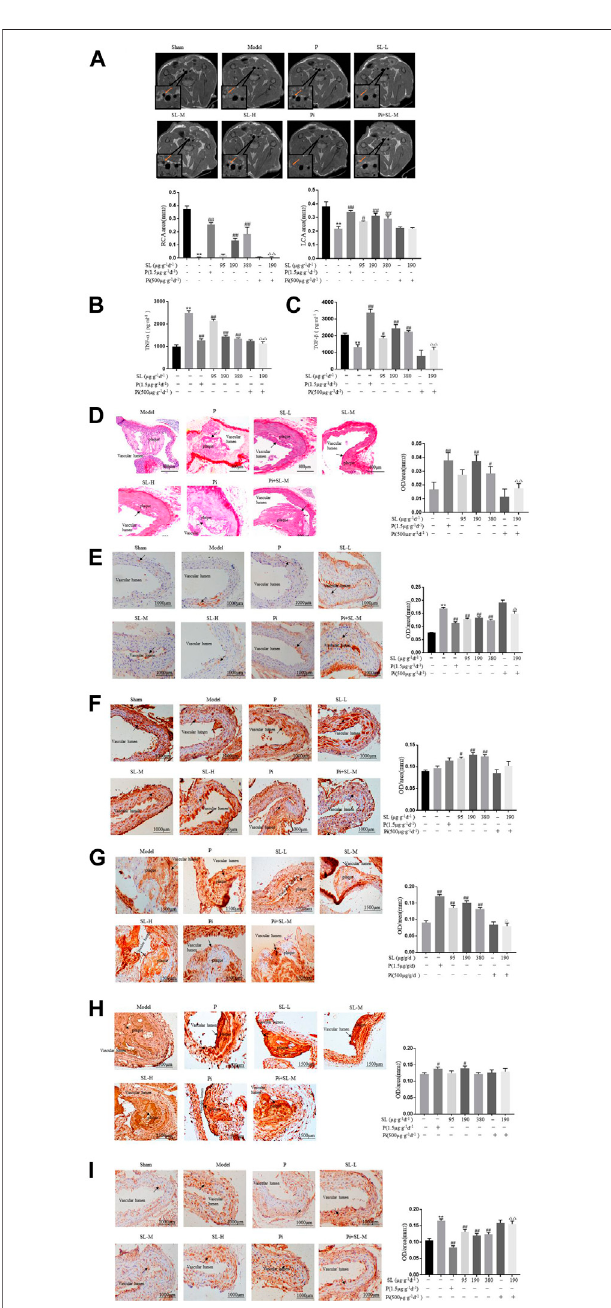
FIGURE 5 | Speci fi c blocking of TGF- β attenuated the functional plaque stability provided by SL in ApoE-/- mice. (A) Carotid artery coronal images captured by NMR and measurements of areas of the RCA and LCA. (B, C) TNF- α and TGF- β in the serum of treated were detected by ELISA. (D) Intravascular Sirius red, Scale bar, 800 μ m. (E, F) IHC analysis and measurement of atherosclerotic aortic root, the expression of M1 macrophage polarization related marker CD86 and M2 macrophage polarization related marker CD206, Scale bar, 1000 μ m. (G, H) IHC analysis and measurement of plaque, the expression level of contractile SMCs related markers α -SMA, ECM related marker Fibronectin, Scale bar, 1500 μ m. (I) IHC analysisforMMP9,Scalebar,1000 μ m.* p < 0.05and** p < 0.01comparedto the sham-treated group, and # p < 0.05 and ## p < 0.01 compared to model group, P (cid:2) Rosuvastatin, Pi (cid:2) Pirfenidone, n (cid:2)